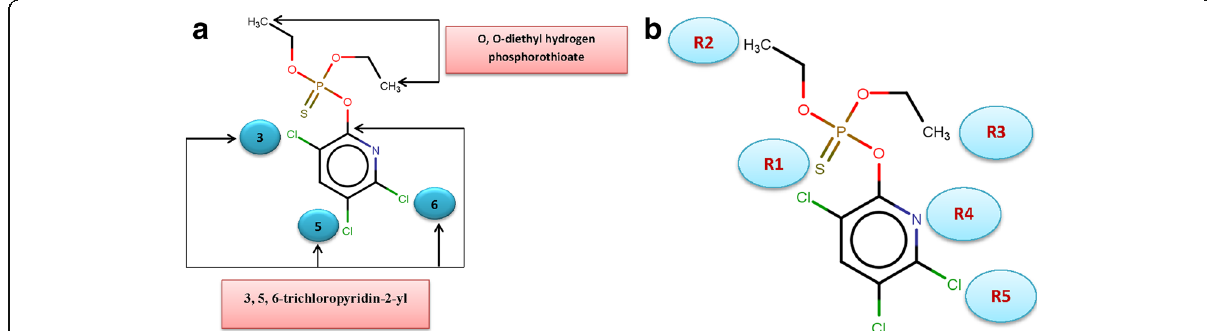
Fig. 3 a Structure of chlorpyrifos. b Structure of chlorpyrifos with linker position (R1 –